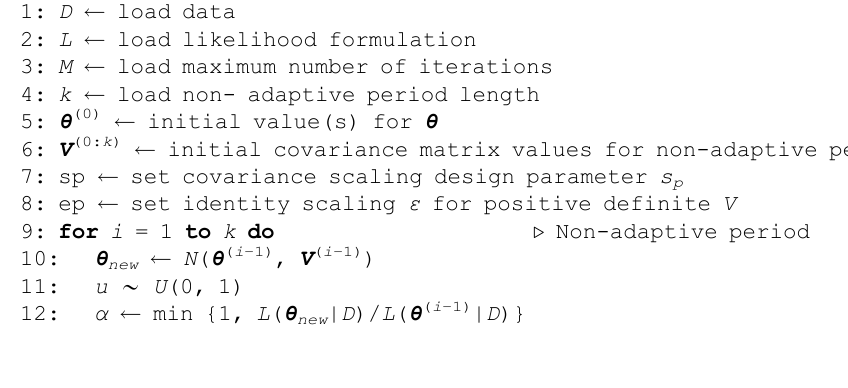
Algorithm 1 Adaptive Metropolis Algorithm